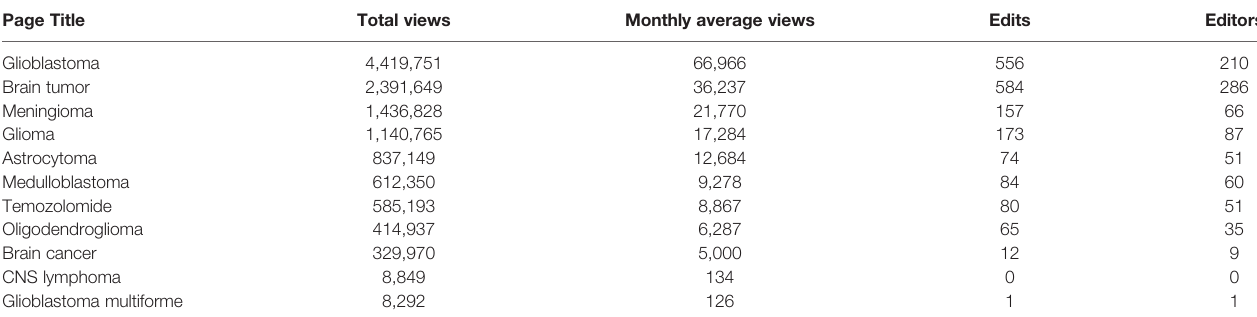
TABLE 2 | Tabulated Pageviews Data from Wikipedia searches. Total views Monthly average views